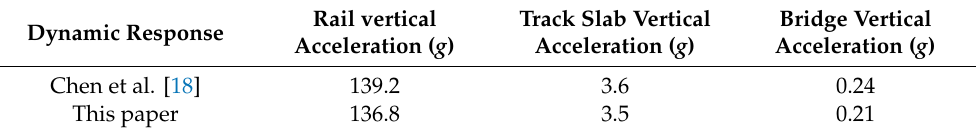
Table 3. Comparisons of the maximum dynamic